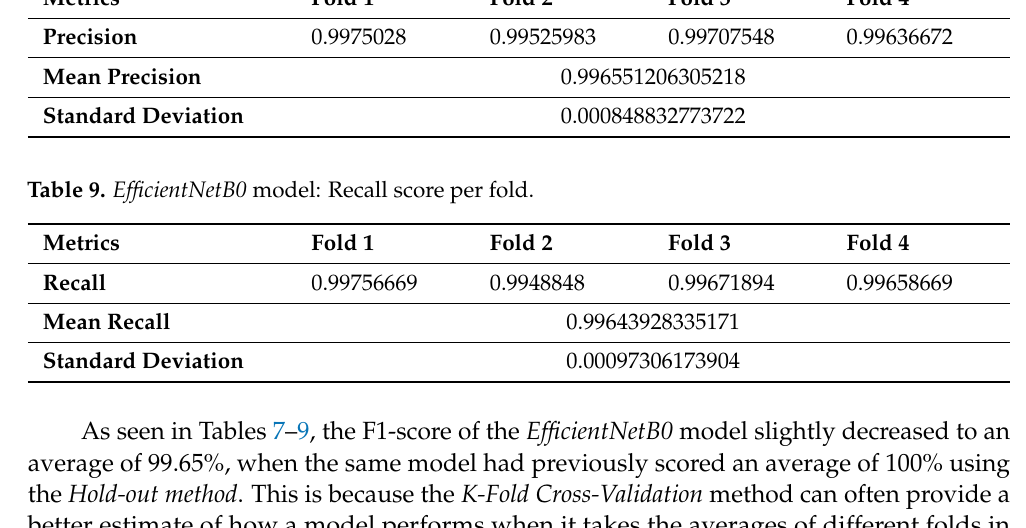
Table 8. EfficientNetB0 model: Precision score per fold. Metrics